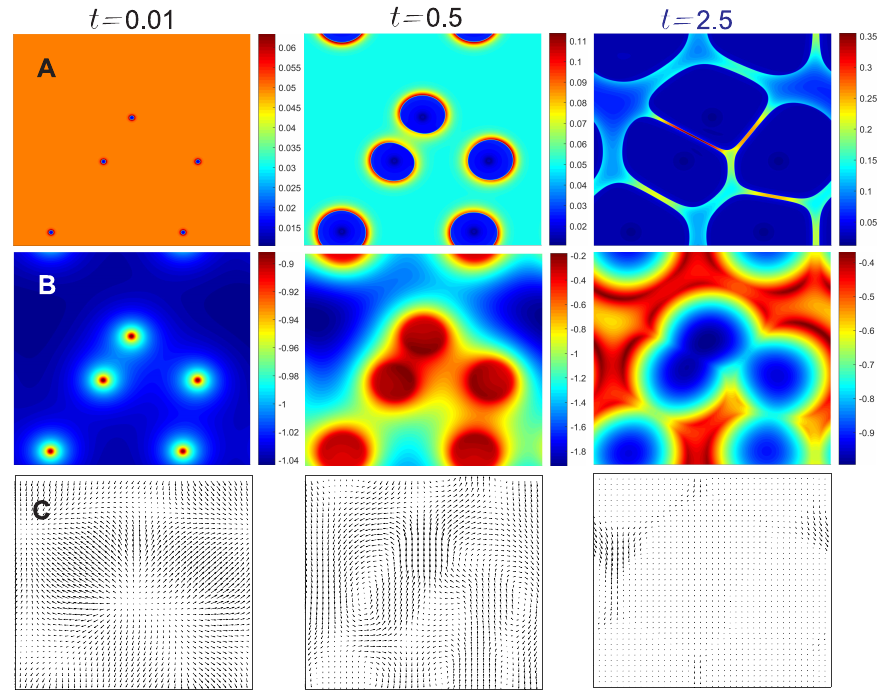
Figure 4. Transient results of solute volume fraction ( A , 1st row), temperature ( B , 2nd row), and scaled velocity vectors ( C , 3rd row) at the corresponding time instants (cid:101) t = 0.01,0.5, and 2.5. Parameters and initial conditions are the same as in Figures 2 and 3, where the results at (cid:101) t = 1.5 have been provided.